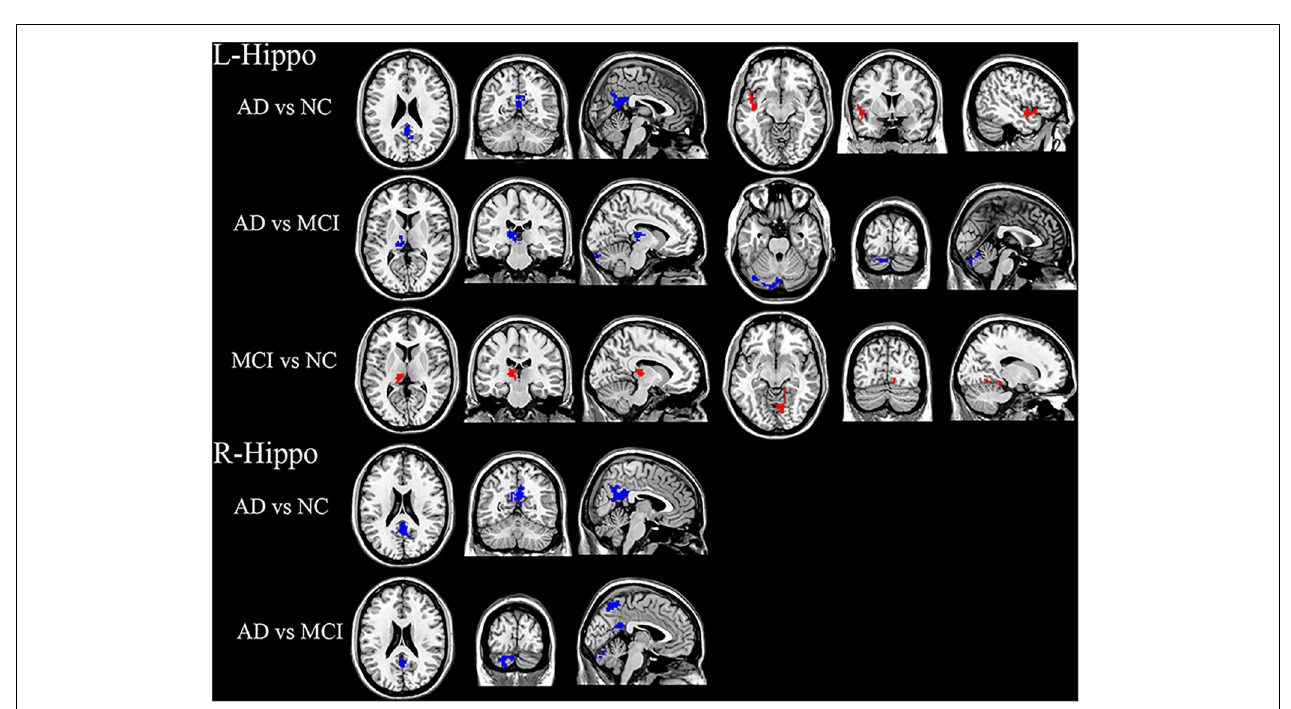
FIGURE 3 | Significant hippocampal FC differences in AD, MCI, and NC groups. For left hippocampal FC: Decreased FC in the PCC, increased FC in the left insula in AD group compared with the NC group. Compared with the MCI group, the AD group showed decreased FC in the left thalamus and cerebellum. The MCI group showed increased FC in the right lingual gyrus and left thalamus compared with the NC group. For right hippocampal FC: FC in PCC was significantly decreased in the AD group compared with NC group. Significantly decreased FC in PCC, precuneus and cerebellum in AD group compared to the MCI group. Blue and red regions indicate decreased or increased FC,